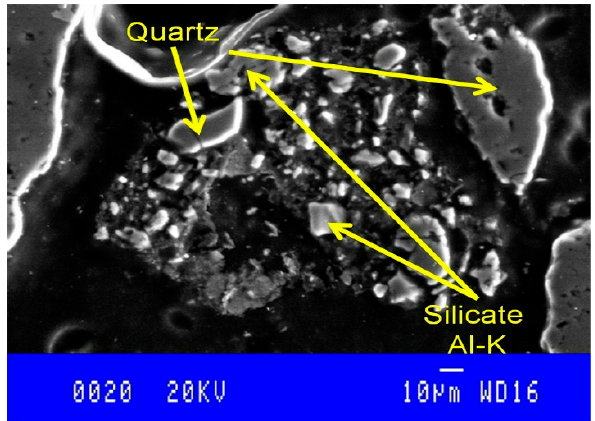
Figure 2. Optical micrograph of the mining residues showing the presence of metal inclusions of pyrite in a quartz matrix.